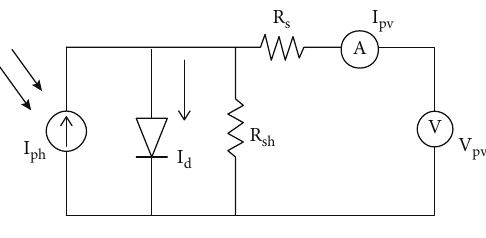
Figure 3: Circuit of equivalence –